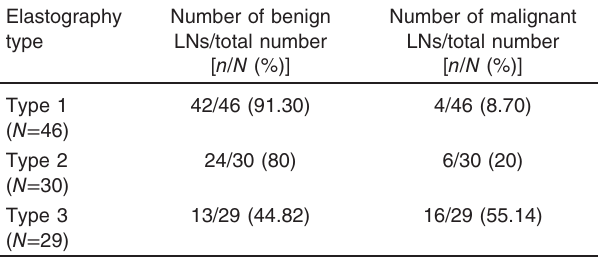
Type 1 group: largely nonblue (green, yellow, and red). Type 2 group: part blue, part nonblue (green, yellow, and red). Type 3 group: largely blue.